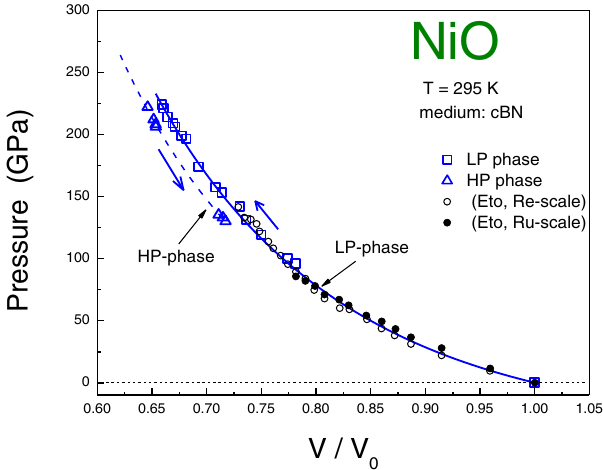
Fig. 7 The experimental relation pressure-volume dependence in NiO at non-hydrostatic conditions. The fi gure combines values of the relative volume change V/V 0 obtained from our nonhydrostatic experiment (run5) and from Eto ’ s et al work (Ref. 14 ). The open triangles correspond to high- pressure phase (HP). For comparison are shown previous experimental data from Eto ’ s et al. work (Ref. 14 ) — circles (open circles — Re calibrated pressure, closed circles — Ruby calibrated pressure). The Birch-Murnaghan equation of state was fi tted to the experimental data (run5), and its parameters were found are equal the bulk modulus B 0 = 216 ± 15 GPa and its derivative B ’ = 4.3 ± 0.4. The solid line — calculated Birch-Murnaghan equation of state fi ts very well all set of experimental points including previous one (Ref. 14 ). With a pressure increase in the range of 206 – 224 GPa the onset of the isostructural transition was observed with a volume drop of about 2.7%. In our non-hydrostatic experiment (run5) we observed a coexistence of high- and low-pressure phases in a wide pressure interval from ~230 to ~130 GPa at decompression. For the HP phase, we used fi t of non-hydrostatic experimental data for the modi fi ed Birch-Murnaghan equation of state (Supplementary Note 5) and its parameters were found are equal to bulk modulus B 130 = 699 ± 6 GPa its derivative B 130 ’ = 4.0 ( fi xed) with initial pressure parameter of 130 GPa.